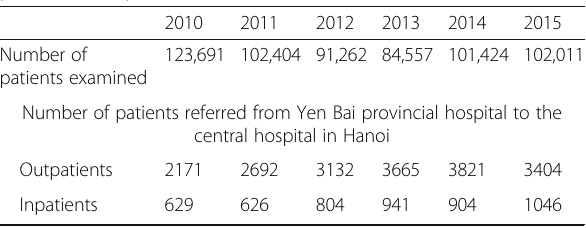
Table 3 Trend in patient examinations and transfers at Yen Bai provincial hospital (2010 –